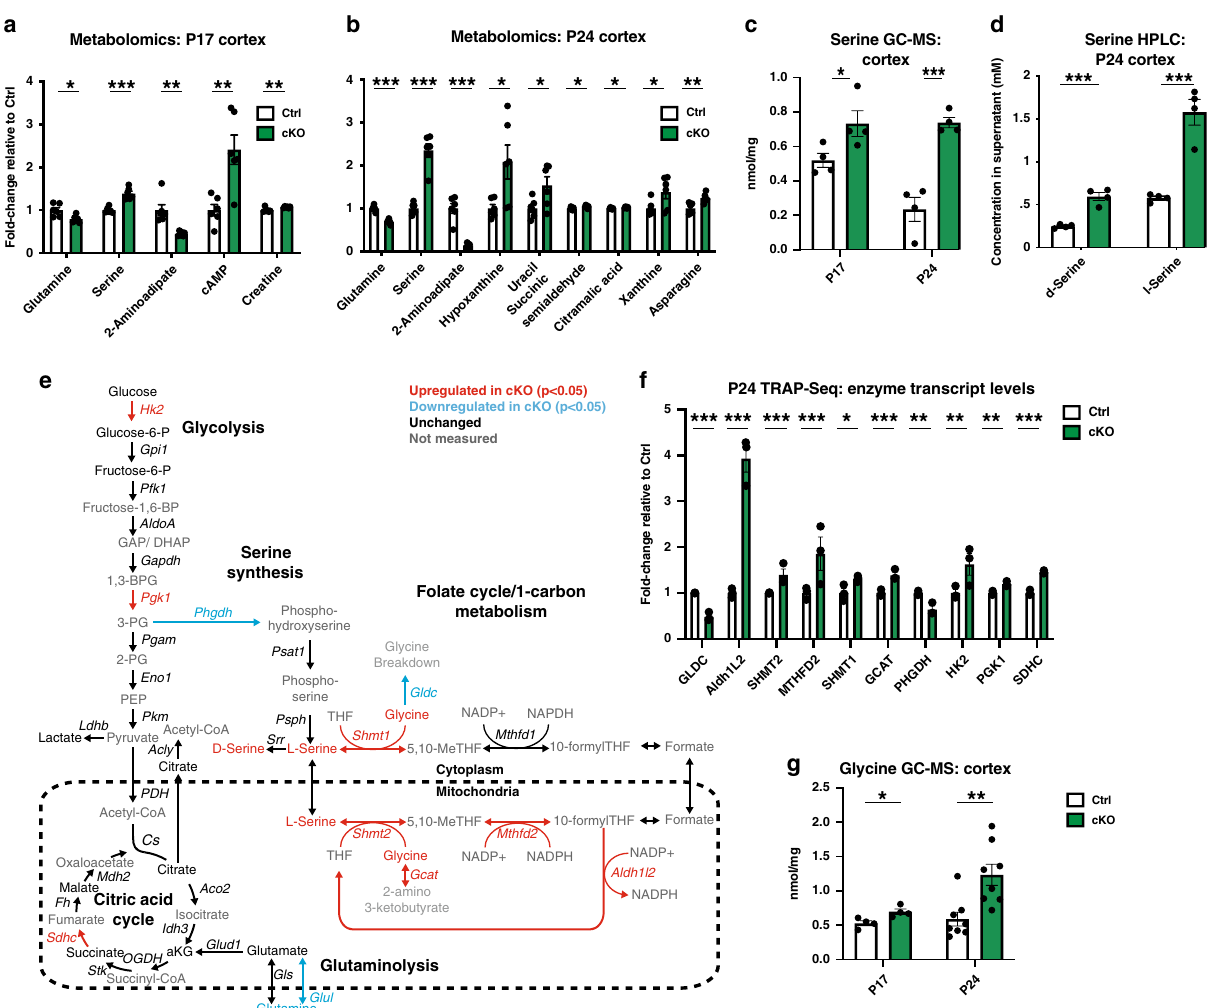
Fig. 5 Levels of serine and glycine are elevated in the cerebral cortex of conditional α 2-Na/K ATPase knockout mice. a Metabolomics was performed on fl ash-frozen cerebral cortex from P17 conditional α 2-Na/K ATPase knockout (cKO) and sex-matched littermate f/f or f/ + control (Ctrl) mice. Only signi fi cantly altered metabolites are shown. Data are presented as mean ± s.e.m. * P < 0.05, ** P < 0.01, *** P < 0.001 (two-tailed t test, n = 6 mice per group). b Metabolomics was performed on fl ash-frozen cerebral cortex from P24 cKO and Ctrl mice. Only signi fi cantly altered metabolites are shown. Data are presented as mean ± s.e.m. * P < 0.05, ** P < 0.01, *** P < 0.001 (two-tailed t test, n = 6 mice per group). c The cerebral cortex from perfused P24 and P17 cKO and Ctrl mice was subjected to gas chromatography – mass spectrometry (GC – MS) for serine levels. The levels of serine were robustly elevated in the cerebral cortex of conditional α 2-Na/K ATPase knockout mice. Data are presented as mean ± s.e.m. * P < 0.05, *** P < 0.001 (two-tailed t test, n = 4 mice per group, P = 0.046 P17, P = 0.00056 P24). d Flash-frozen cerebral cortex from P24 cKO and Ctrl mice was subjected to high-performance liquid chromatography (HPLC) to quantify levels of D- and L-serine. Data are presented as mean ± s.e.m. *** P < 0.001 (two-tailed t test, n = 4 mice per group, P = 0.00034 D-serine, P = 0.00058 L-serine). e Network constructed by integrating established metabolic pathways relevant to serine biosynthesis with TRAP-Seq data for transcript levels of metabolic enzymes and the metabolomics data for metabolite levels. Red indicates signi fi cant upregulation ( P < 0.05), blue indicates signi fi cant downregulation, black indicates no signi fi cant change, and gray indicates an unmeasured metabolite. f Fold change of selected metabolic enzymes in the TRAP-Seq for cKO relative to Ctrl mice. Data are presented as mean ± s.e.m. * P < 0.05, ** P < 0.01, *** P < 0.001 (false discovery rate (FDR), n = 3 mice per group). g The cerebral cortex from perfused P24 and P17 cKO and Ctrl mice was subjected to GC – MS for glycine levels. The levels of glycine were robustly elevated in the cerebral cortex of conditional α 2-Na/K ATPase knockout mice. Data are presented as mean ± s.e.m. * P < 0.05, ** P < 0.01 (two-tailed t test, n = 4 mice at P17, 8 at P24, P = 0.020 P17, P = 0.0035